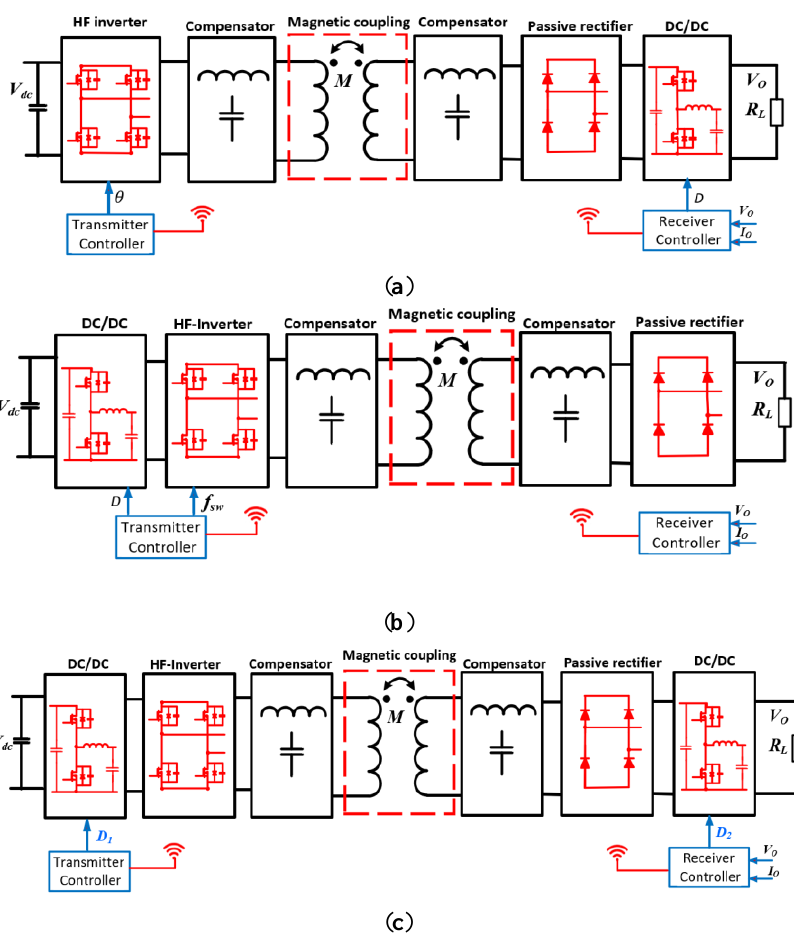
Figure 12. PE structure with auxiliary DC-DC converter: ( a ) with the dc-dc converter on the secondary side, ( b ) dc-dc converter on the primary side, and ( c ) dc-dc converters on both sides.